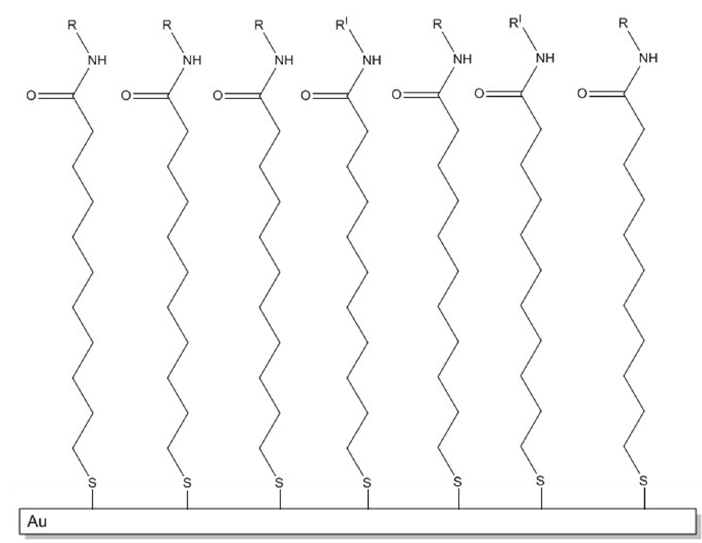
Figure 5. Schematic representation of SAM association with ampicillin 10 − 2 M ( R ) and inactivation of –COOH groups which may have not reacted by ethanolamine ( R’ ).